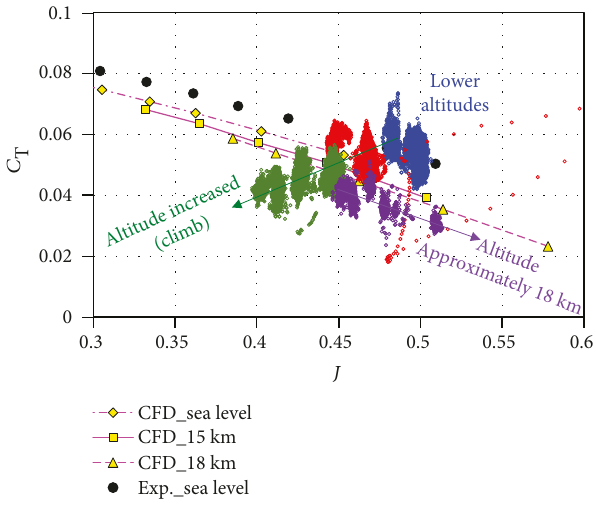
Figure 27: Comparison of thrust coe ffi cient results.